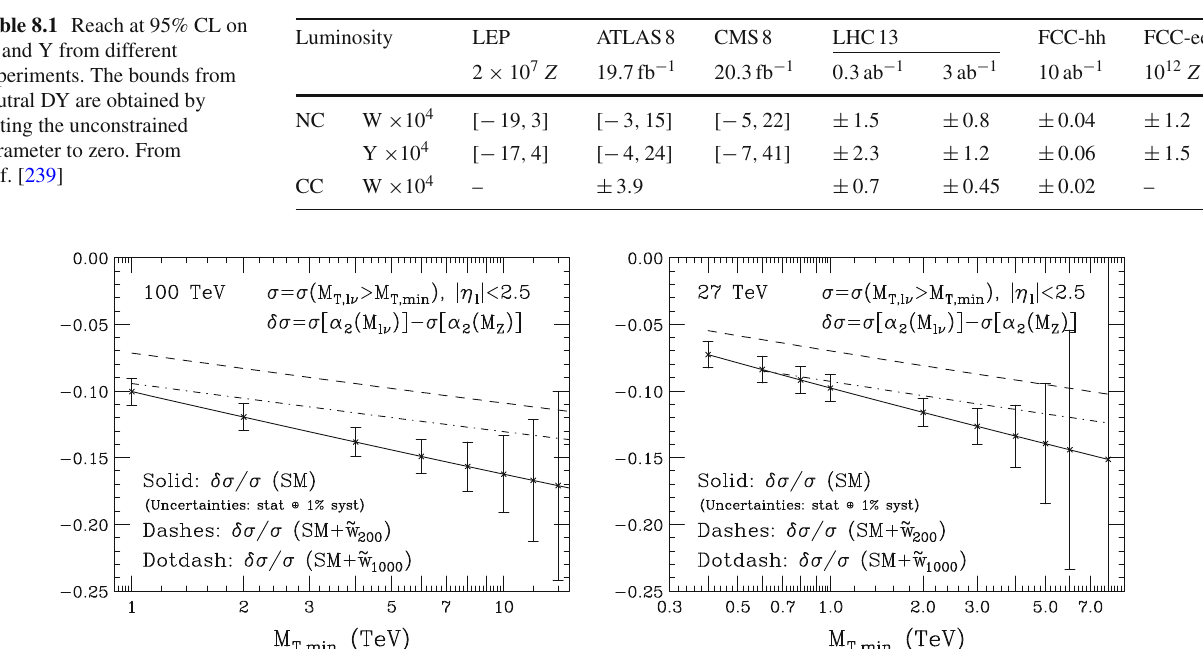
Fig. 8.3 Corrections to the lepton transverse mass distribution in pp → W ∗ → (cid:13) ν due to the running of the SU ( 2 ) coupling α 2 , at 100 and 27